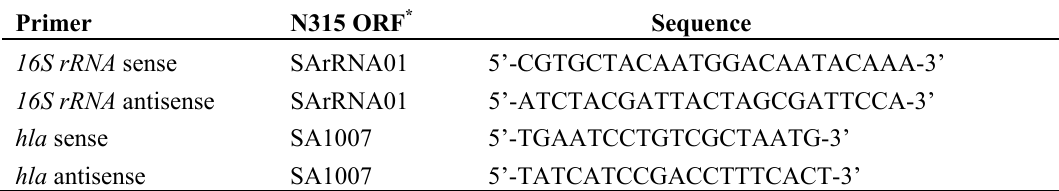
Table 1. Primers used for Real-time